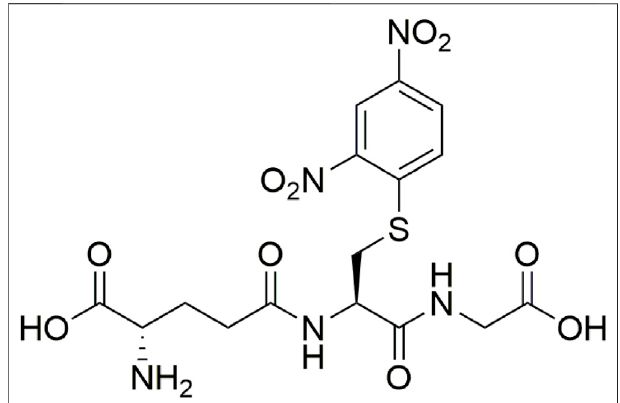
FIGURE 3 | Chemical structure associated with mass/charge ratio for the reaction product between GSH and